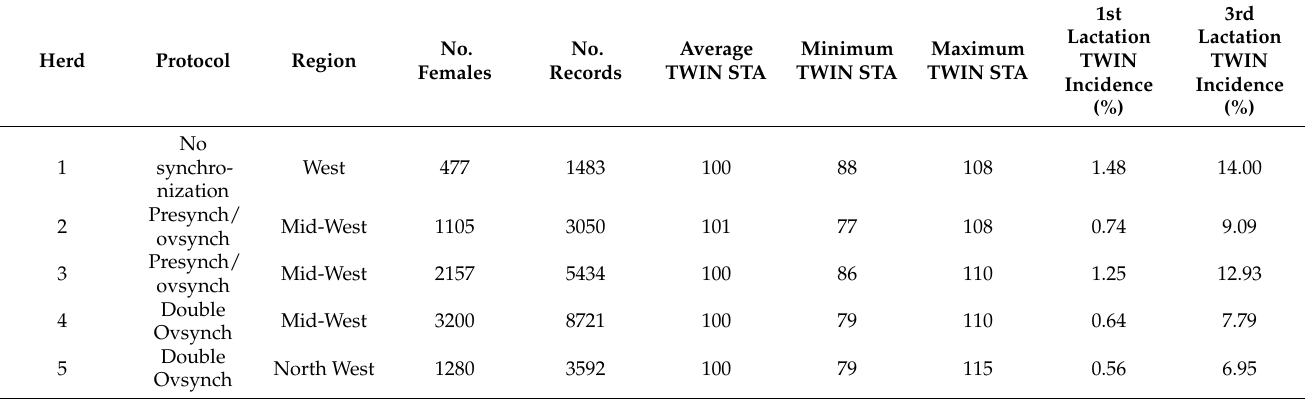
Table 7. Overview of the 5 herds used in the demonstration cohort including reproductive protocol used, region of the US the farm is located, total number of females, total number of calving records, average TWIN STA, minimum TWIN STA, maximum TWIN STA, 1st lactation incidence of twinning and 3 rd lactation twinning incidence.